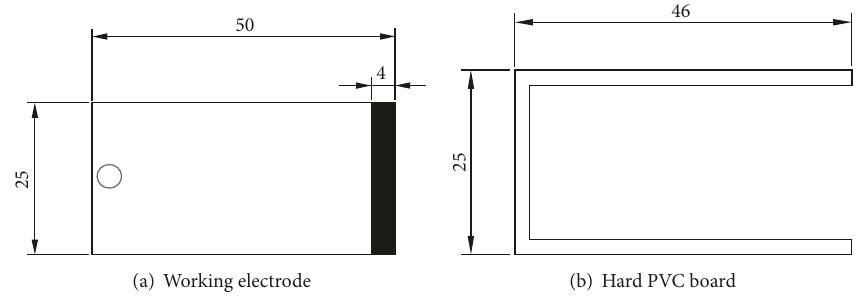
Figure 1: The diagram of the device.